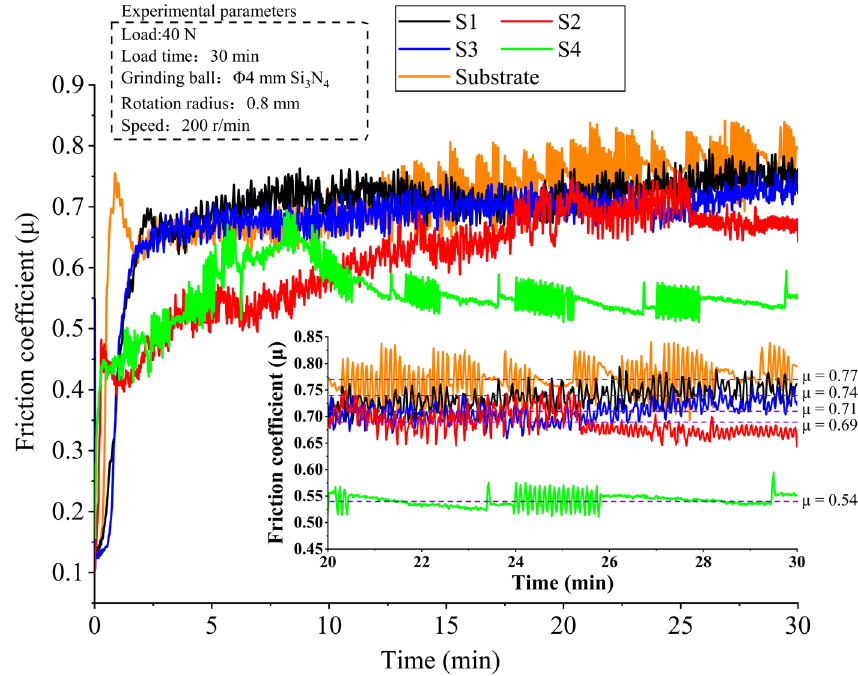
Figure 12. Friction coefficient curves of the substrate and the Stellite 6/WC composite coatings of different